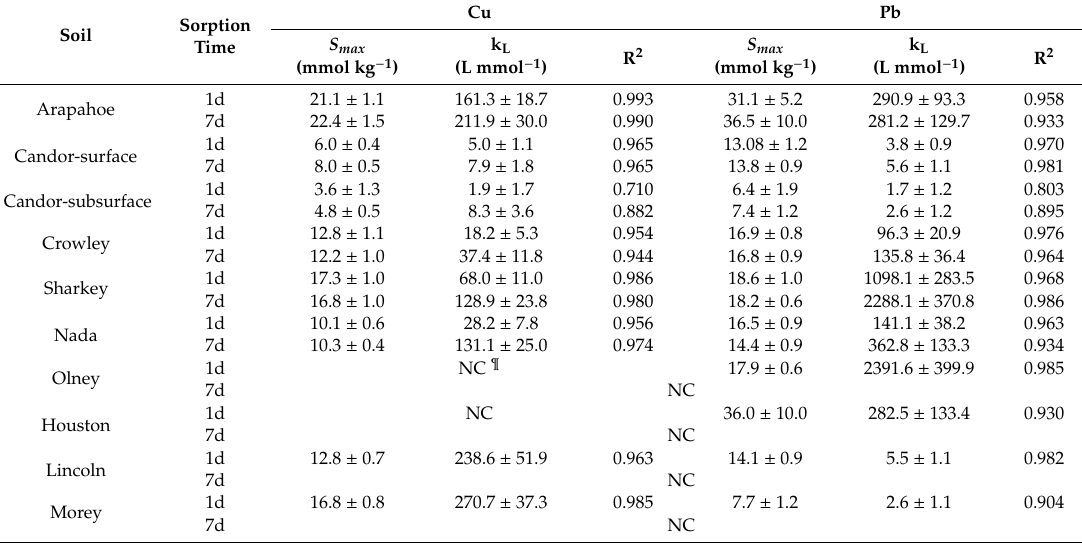
Figure 2. Experimental 1- and 7-days-sorption isotherms of Cu and Pb for alkaline soils. Table 2. Estimated Langmuir Cu and Pb sorption parameters ± standard errors and coe ffi cients of determination (R 2 ) for di ff erent soils after 1- and 7-days.